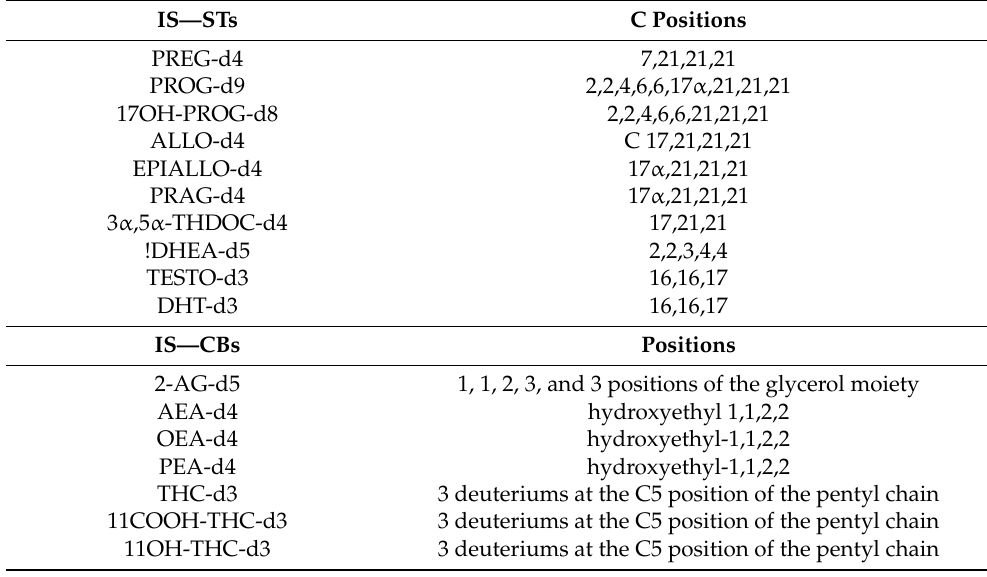
Table 1. Position of the deuterium atoms of the internal standards (ISs) as deuterated analogues of the STs and CBs of